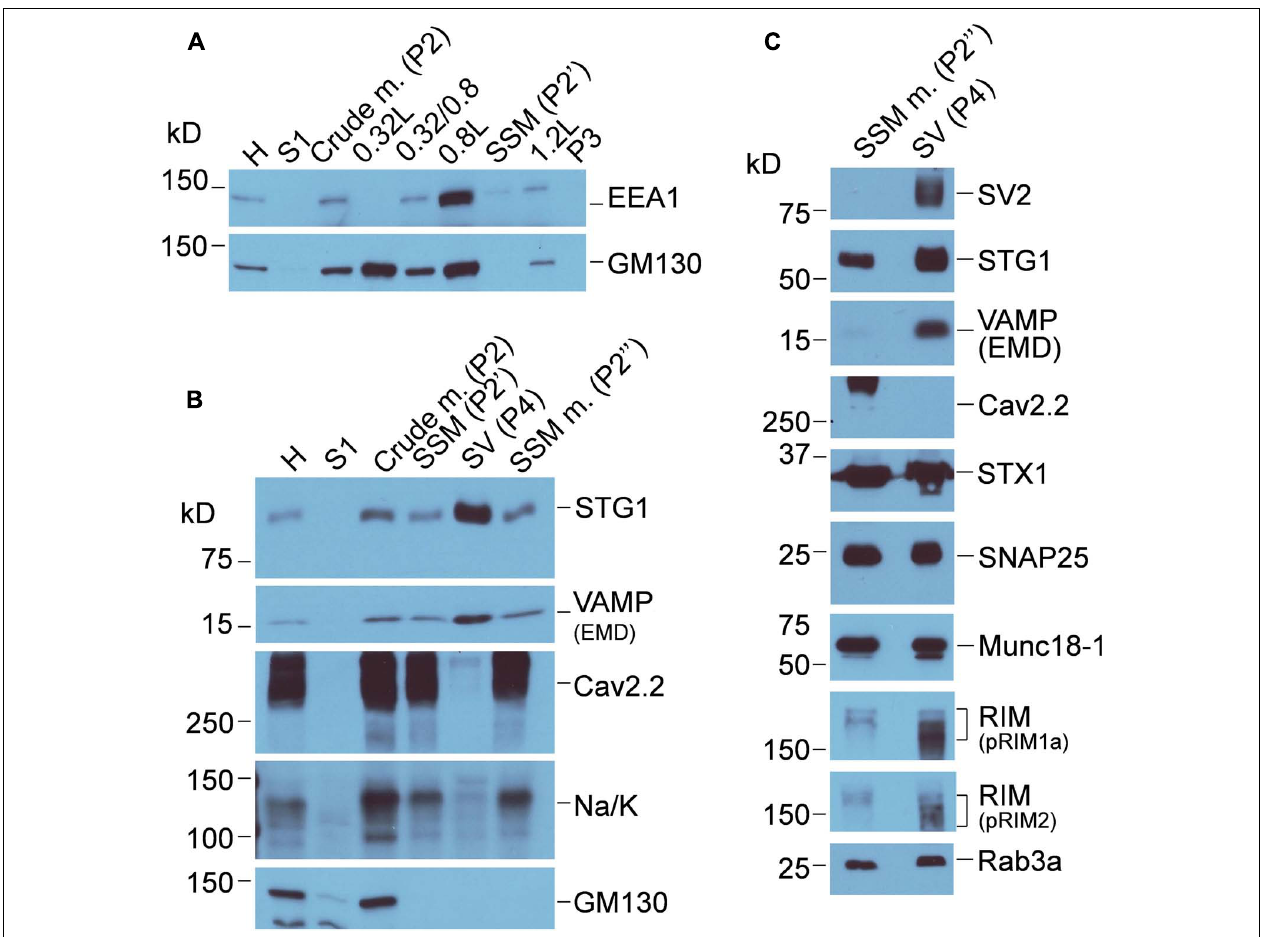
FIGURE 3 | Characterization of chick brain fractions. (A) Western blot of fractions from the first sucrose gradient probed for EEA1 (EEA1, early endosome marker 1) and (GM130 Golgi matrix protein 130), markers of endosome and Golgi membranes, respectively. Crude m., crude brain membranes; SSM, synaptosome. (B) Sucrose gradient fractions probed for synaptic vesicle (STG1,VAMP), Golgi (GM130) and two surface membrane makers, CaV2.2 and Na/K (Na/K ATPase). SSM m., synaptosome membrane;